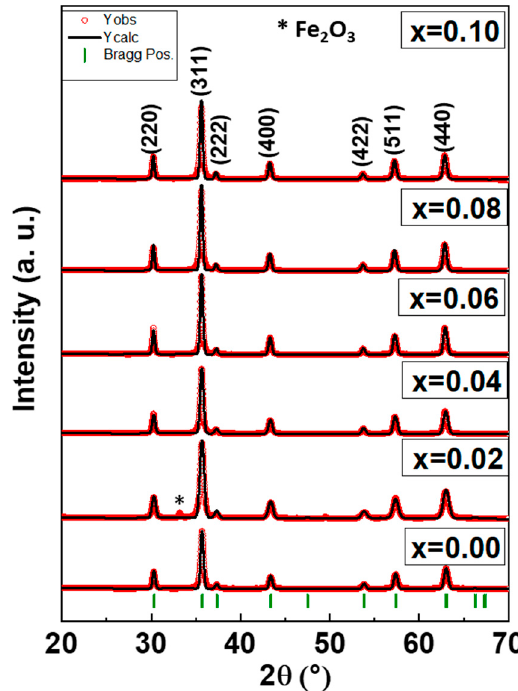
Figure 1. X-raydiffraction(XRD)powderpatternsoftheCo 0.5 Ni 0.5 Nb x Fe 2 − x O 4 (0.0 ≤ x ≤ Figure 1. X-ray diffraction (XRD) powder patterns of the Co 0.5 Ni 0.5 Nb x Fe 2 − x O 4 (0.0 ≤ x ≤ 1.0) nanoparticles.